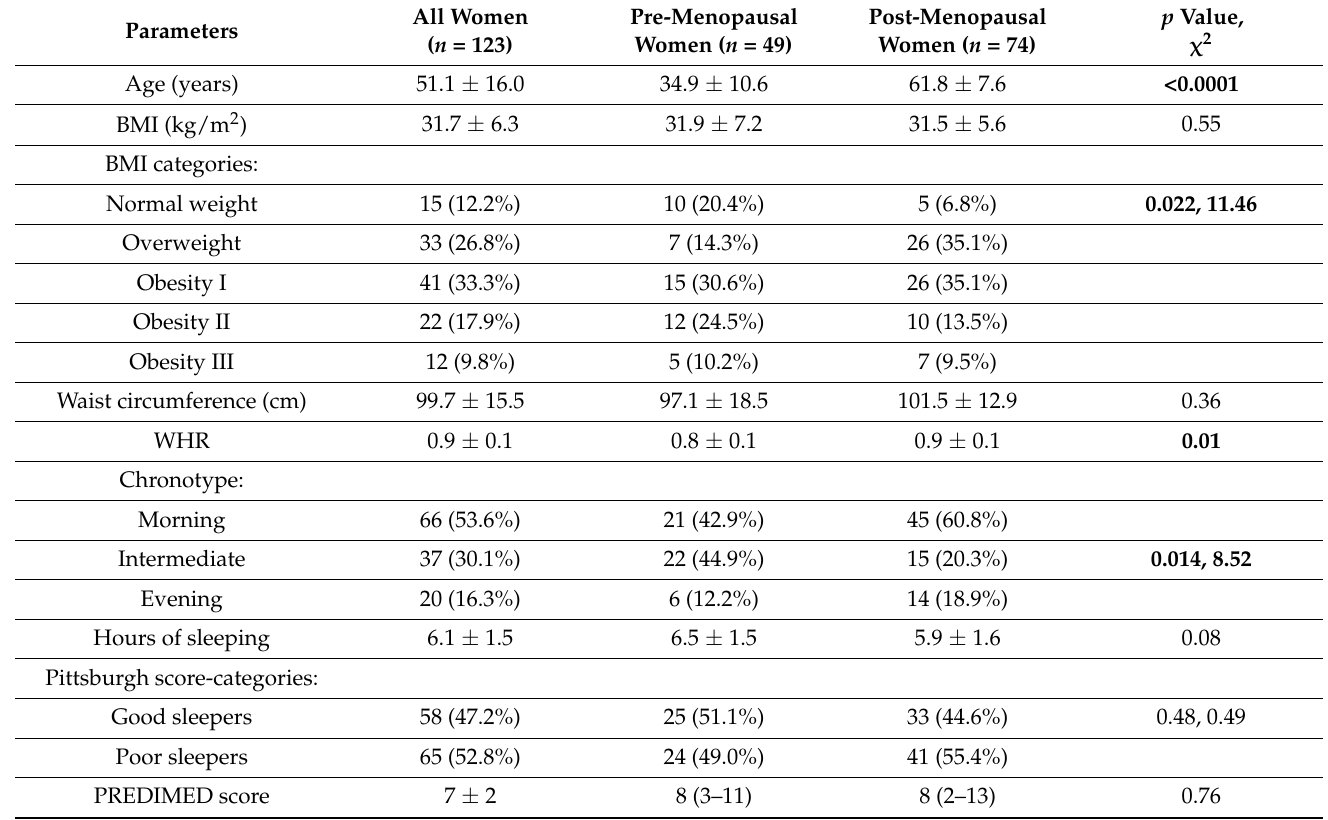
Table 1. Clinical characteristics, lifestyle habits, anthropometric measurements, adherence to the MD, sleep quality and chronotype categories in all cohorts and according to pre/post-menopause.